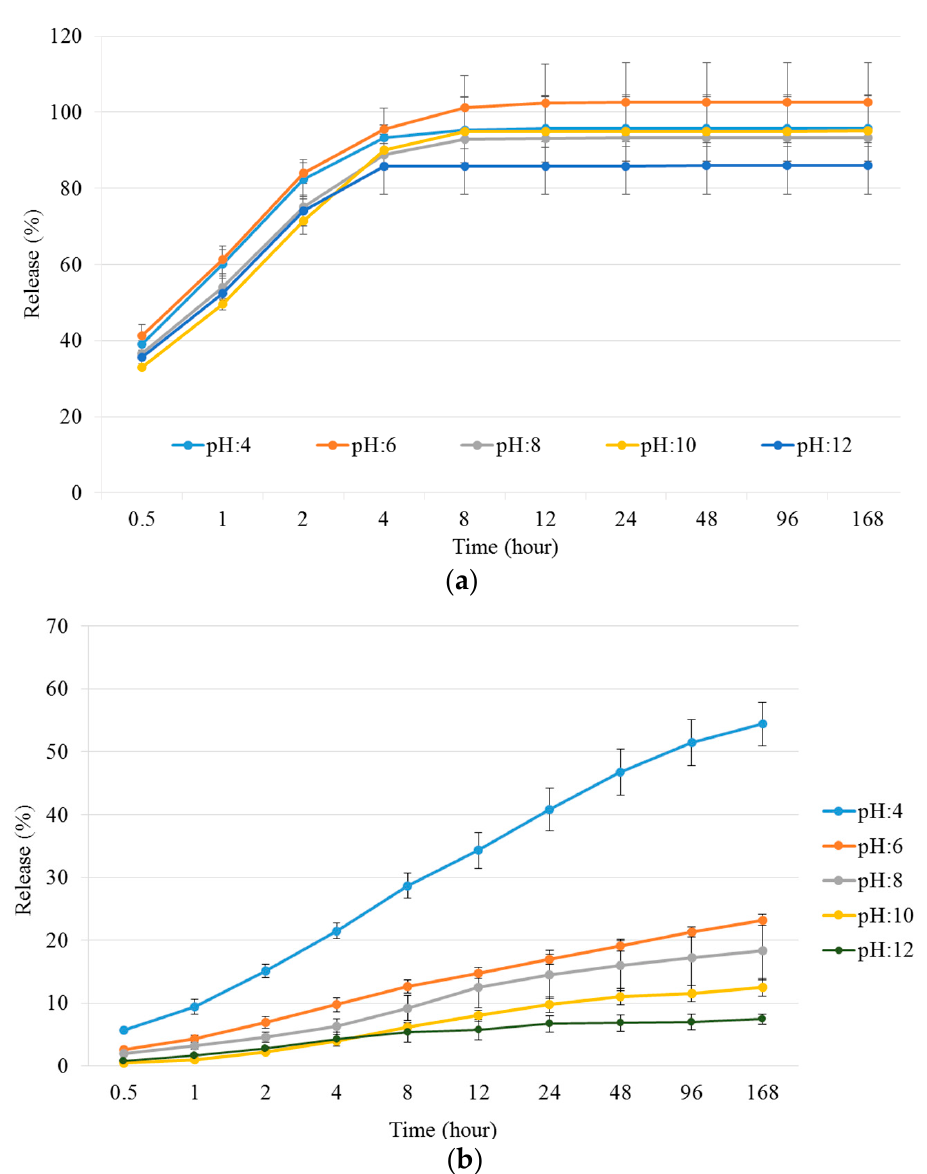
Figure 7. ( a ) Metr and ( b ) CHX release properties of NCHGs in different pH Britton–Robinson buffer solutions over a one week period. Values are expressed as sample means, error bars represent the standard deviation (SD) of three parallel measurements.